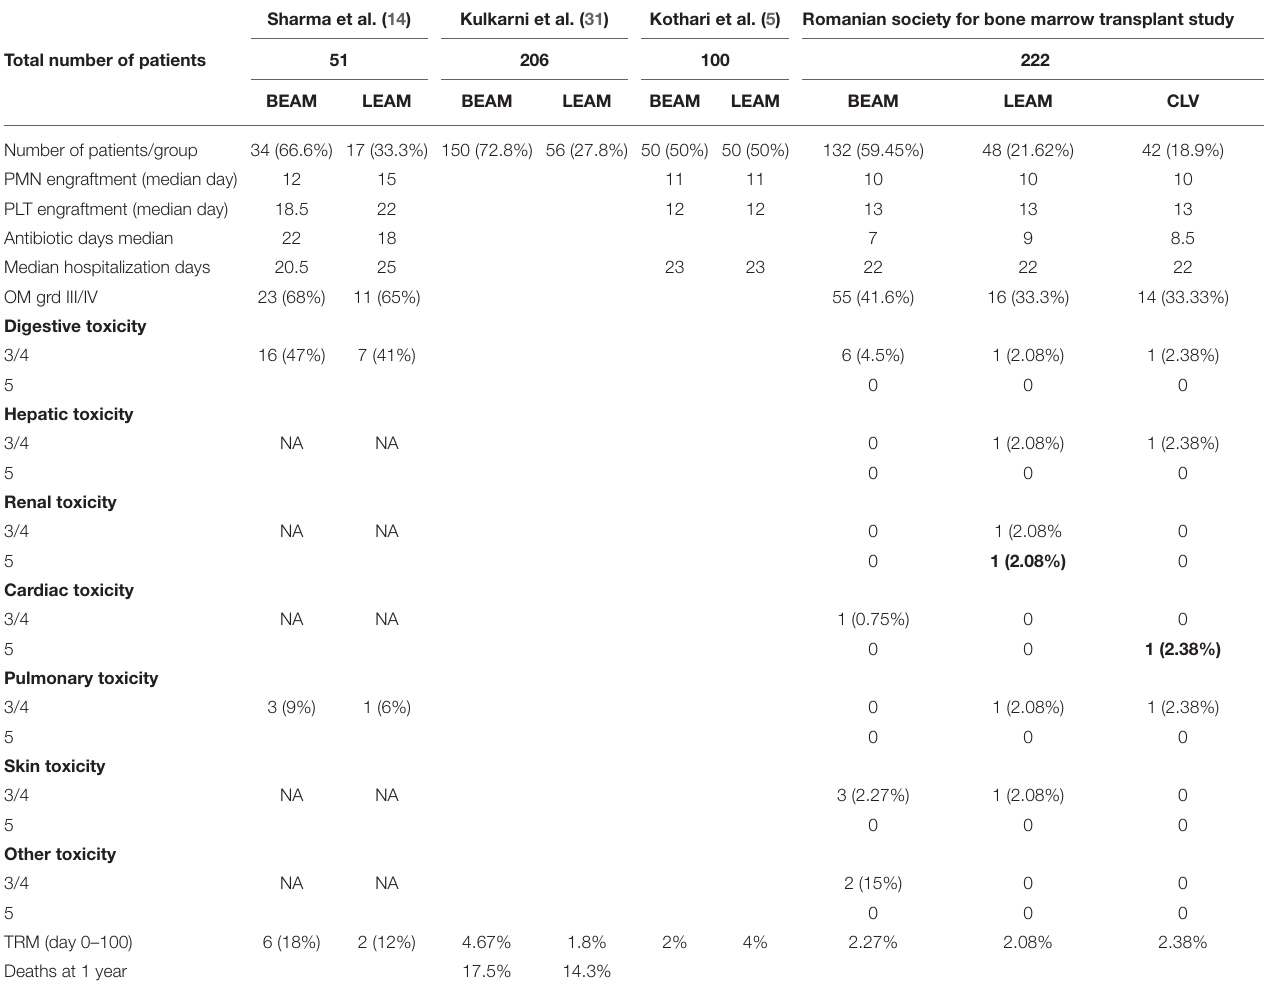
The bold values represent statistically significant